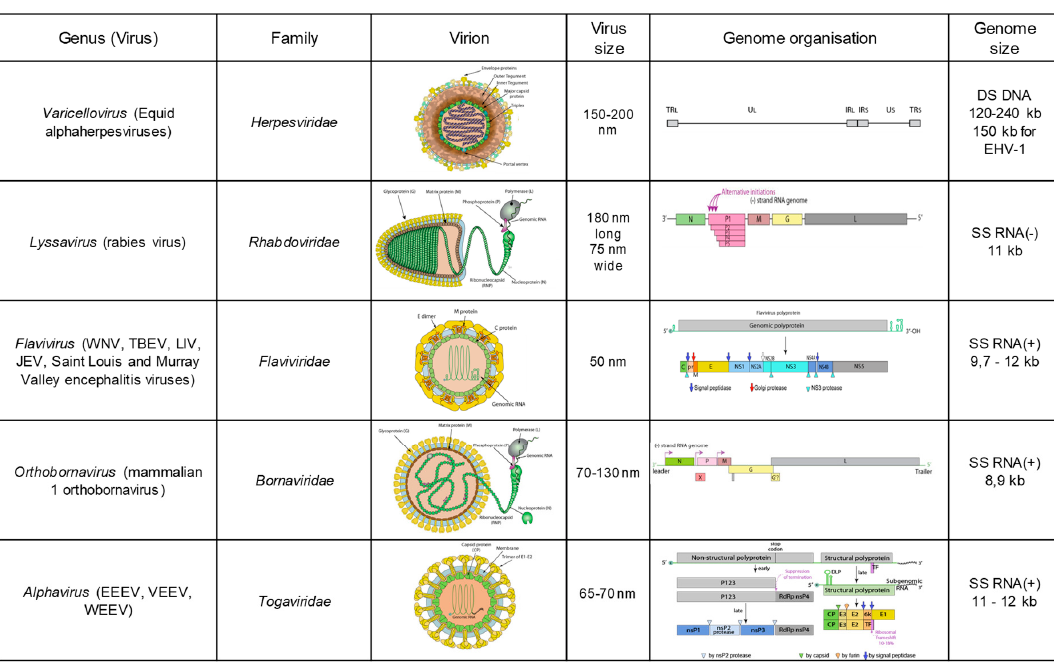
Figure 1. Major viruses causing encephalitis in equines. Virus classification according to ICTV